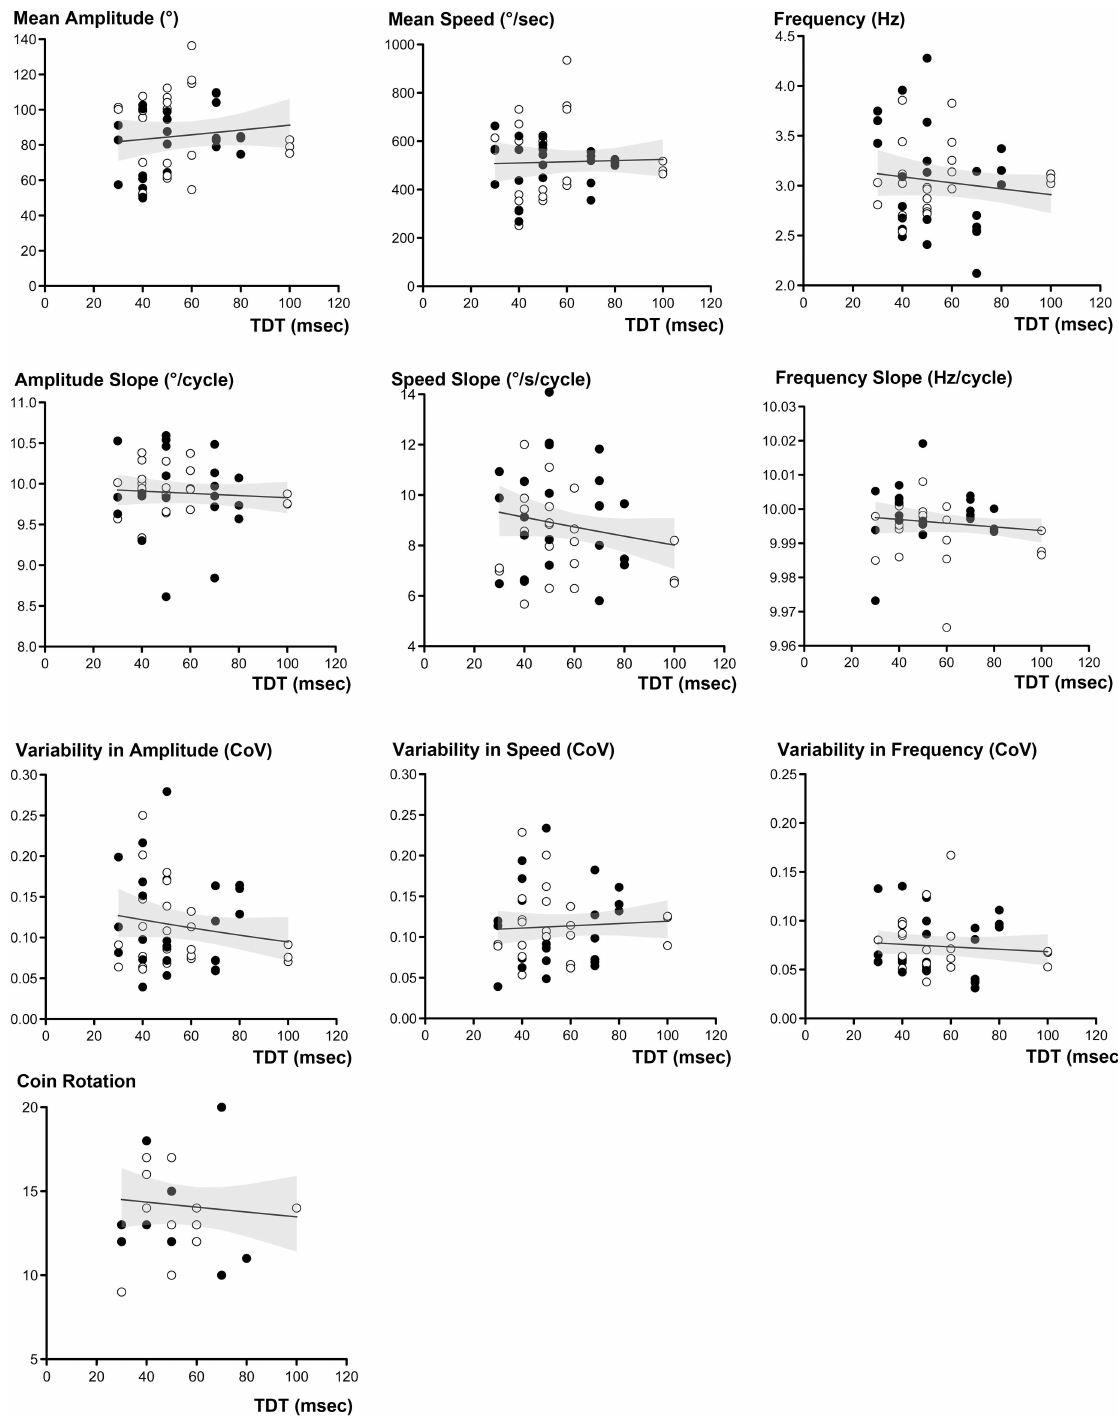
Fig 2. Scatter plots showing the relationship between TDT values and finger movement-related parameters in control group. Slope-relatedparameters were transformed to positive values by addinga constant (+10). Open circles representthe left side hand and filled circles represent the right side hand. The fitted line representsthe predictedmean responsein the GEE model (predictor= TDT values, response = finger movement-related parameters), and the shadedarea indicates95% confidence interval. TDT = temporaldiscrimination threshold; CoV = coefficientof variance)